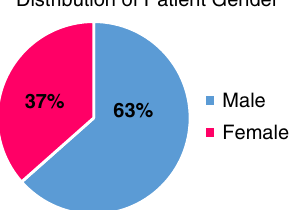
Figure 1. Distribution of patient gender.